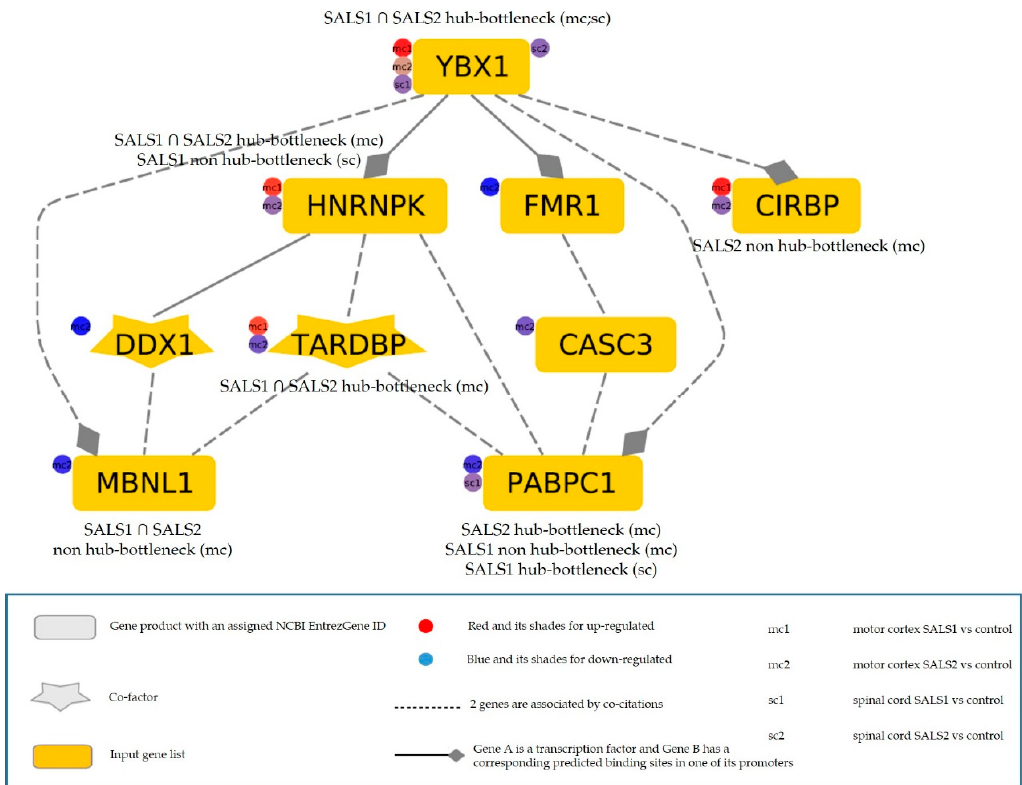
Figure 7. Literature-based network of tissue-specific deregulated genes involved in stress granule formations generated by the Genomatix Pathways System (GePS). The hierarchical layout has been used to highlight the main direction or information flow of the network. The legend below reports information about elements in figure.